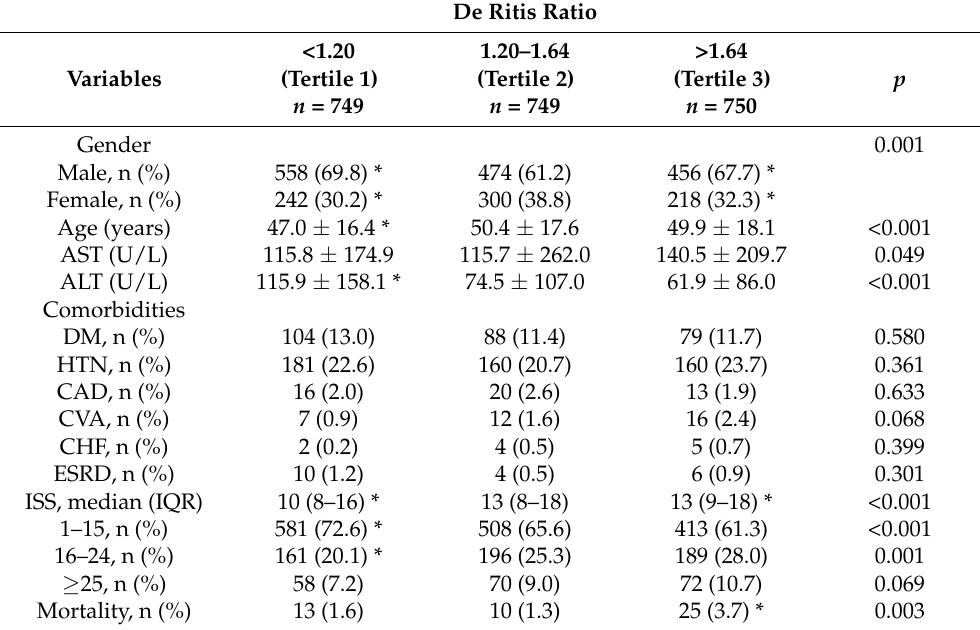
Table 1. Patient and injury characteristics of the study population according to the De Ritis ratio. De Ritis